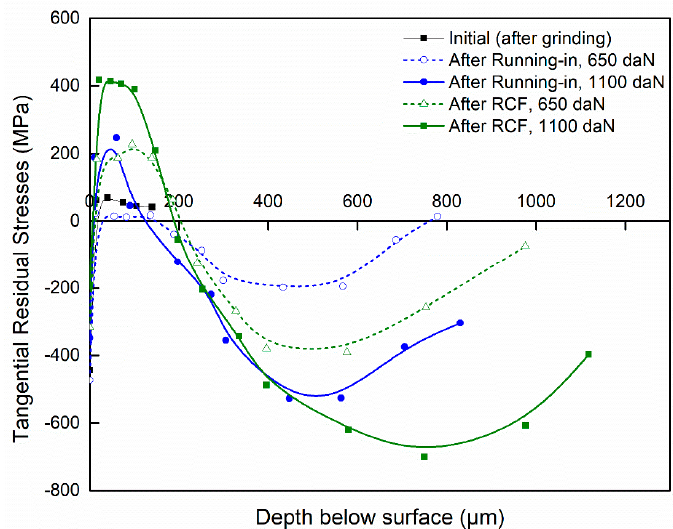
Figure 11. Tangential residual stresses after different phases.